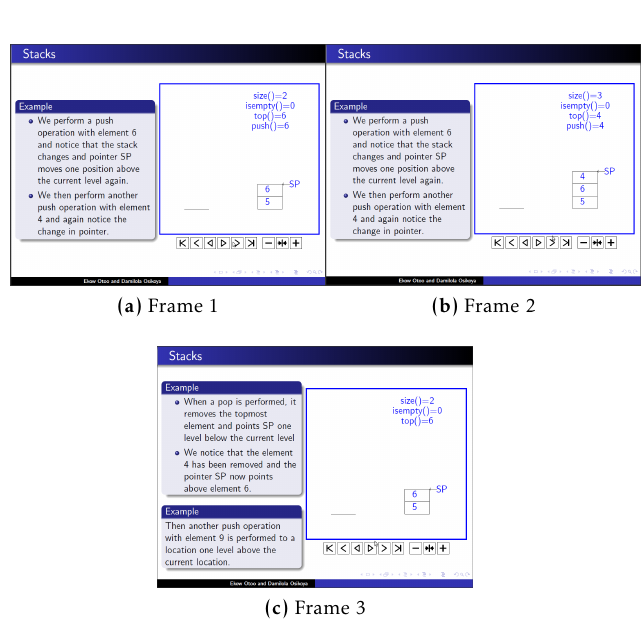
Figure 2. Stack Implementation (Array)